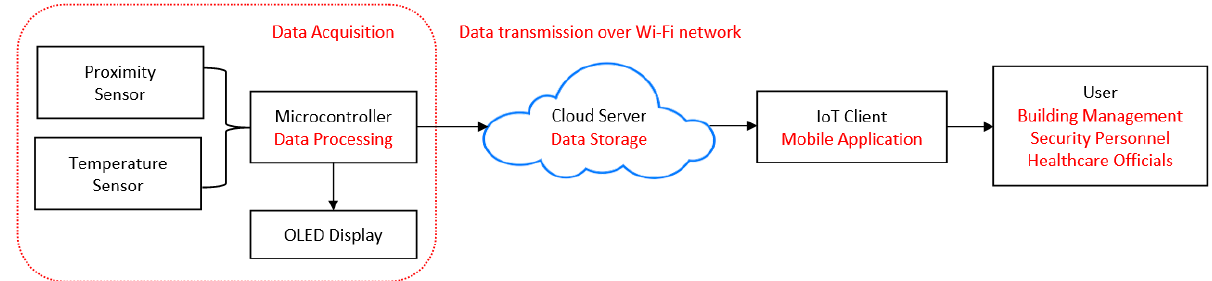
Figure 3. Block diagram of IoT body temperature screening system.